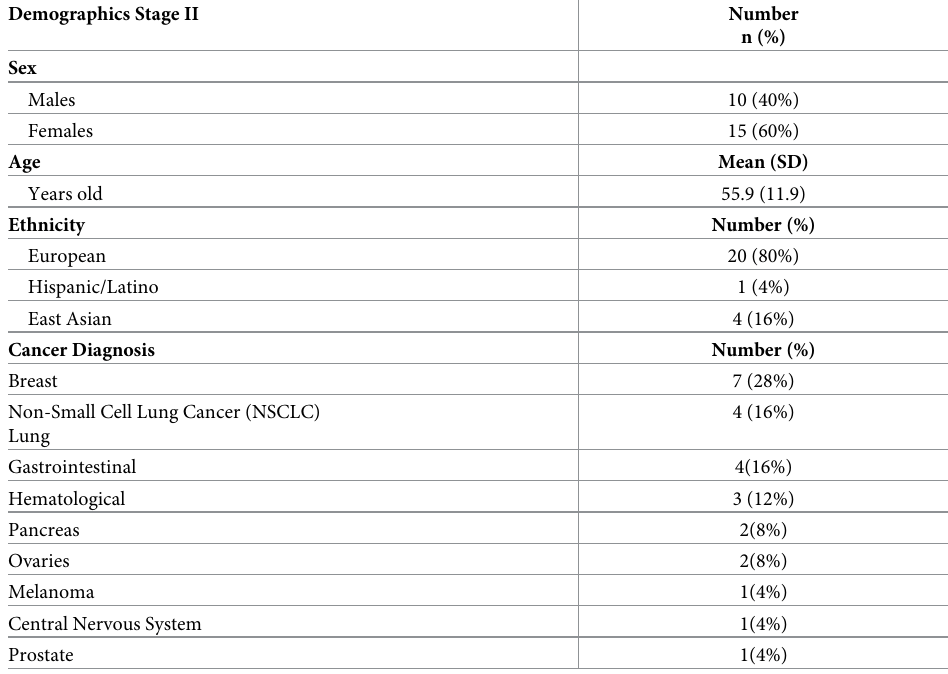
Table 2. Participant baseline demographic and clinical characteristics diagnosed with advanced incurable malig- nancy with uncontrolled pain for Stage II (n = 25